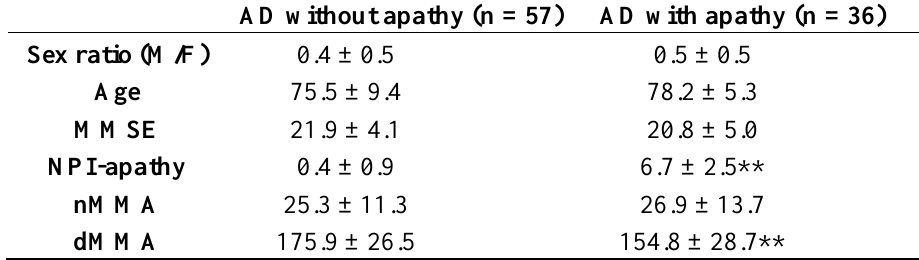
Table 5. Seven-day actigraphic parameters (mean ± SD) for AD patients (with and without apathy. Actigraphic parameters for the two groups and comparison between AD patients without apathy vs. AD patients with apathy ( t -test: p < 0.05*, p < 0.01**); nMMA= nighttime mean motor activity, dMMA = daytime mean motor activity (arbitrary actigraph